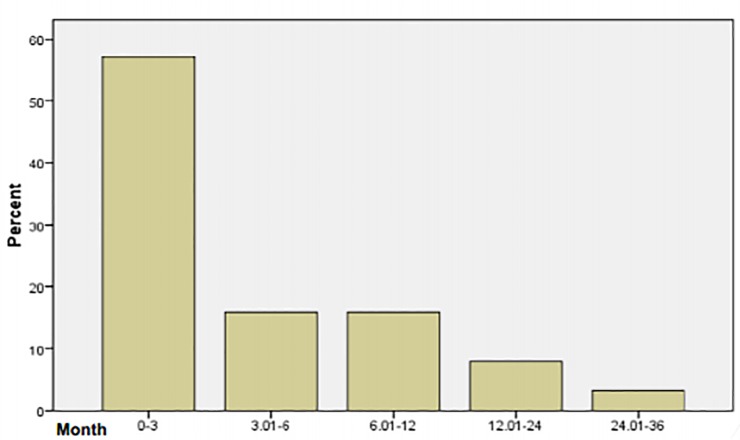
Months AIDS related OIs occurred after initiation of HAART.